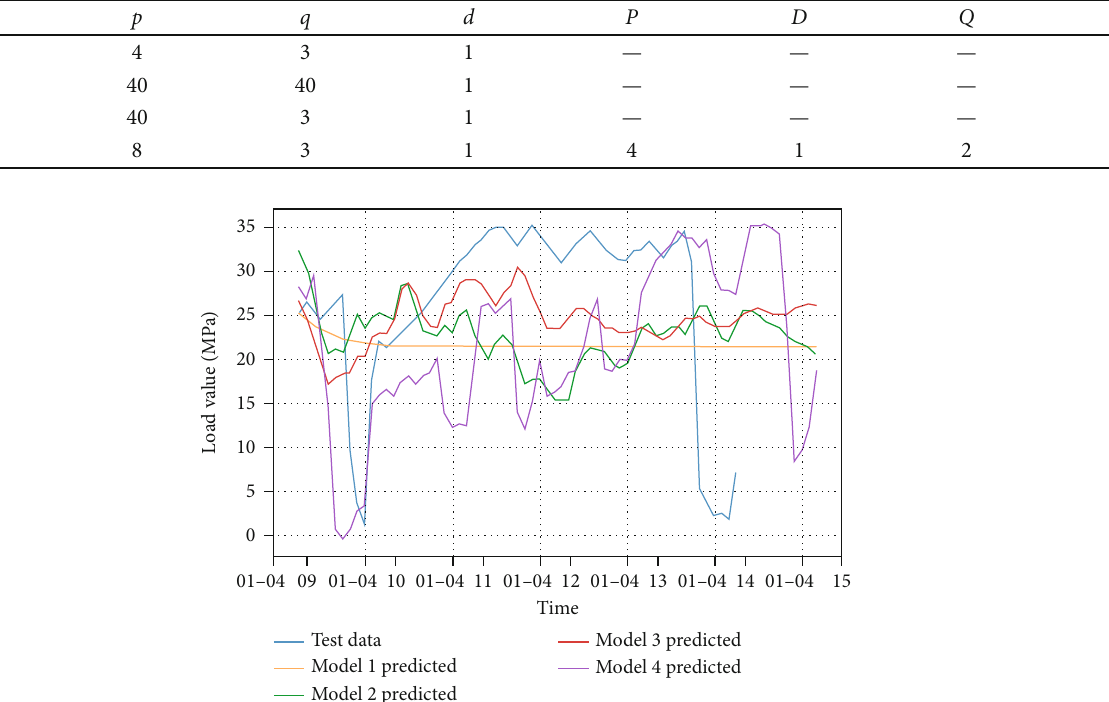
Figure 12: Comparison of prediction results of models and corresponding